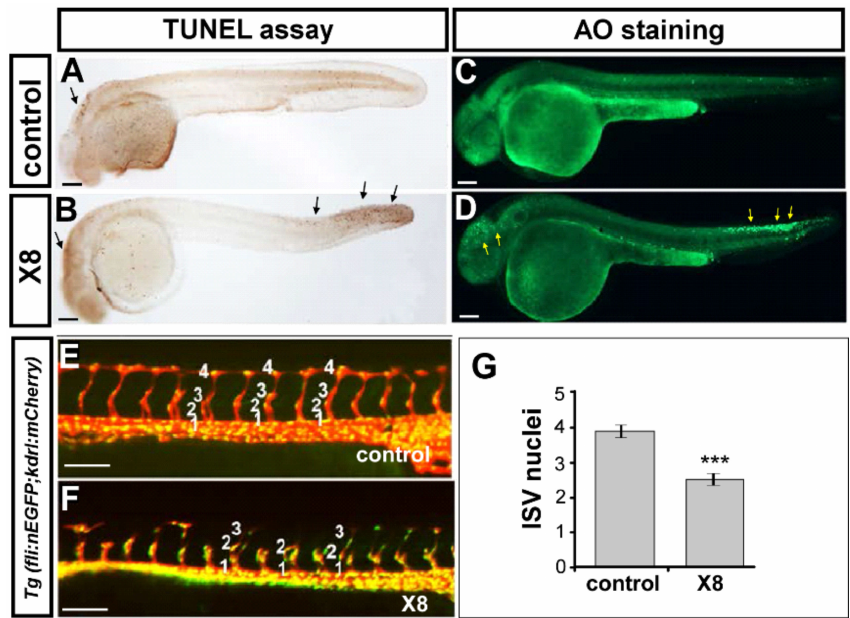
Figure 4. X8 treatment inhibited the growth of ISV cells. ( A – D ) A TUNEL assay and AO staining were used to assay apoptotic cells in wild-type ( A , C ) and X8-treated embryos ( B , D ) at 30 hpf. An increase in apoptotic cells was observed close to the head and tail regions in X8-treated embryos com- pared with untreated control embryos ( B , D ), but no increase was observed in vascular regions ( E , F ). The number of cells forming each ISV was counted in control ( E ) and X8-treated ( F ) Tg(kdrl:mCherry; fli1a:negfp) y7 embryos at 30 hpf. ( G ) Average number of endothelial cells per ISV: 3.9 ± 0.4 (n = 80) and 2.5 ± 0.4 (n = 60) in wild-type and X8-treated embryos, respectively. *** p < 0.0001 by unpaired Student’s t -test. Scale bars: 100 µ m in ( A – F